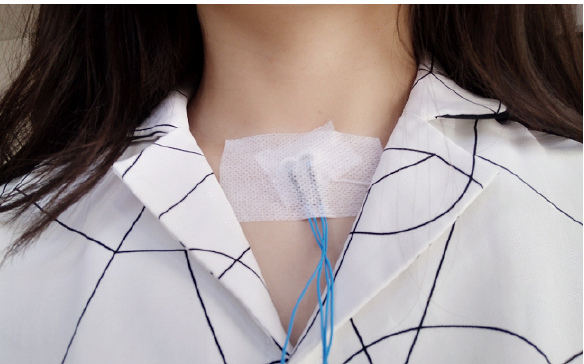
Figure 2. Position of the microphones: two microphones are inserted into the support that is fixed at suprasternal notch with two strips of adhesive